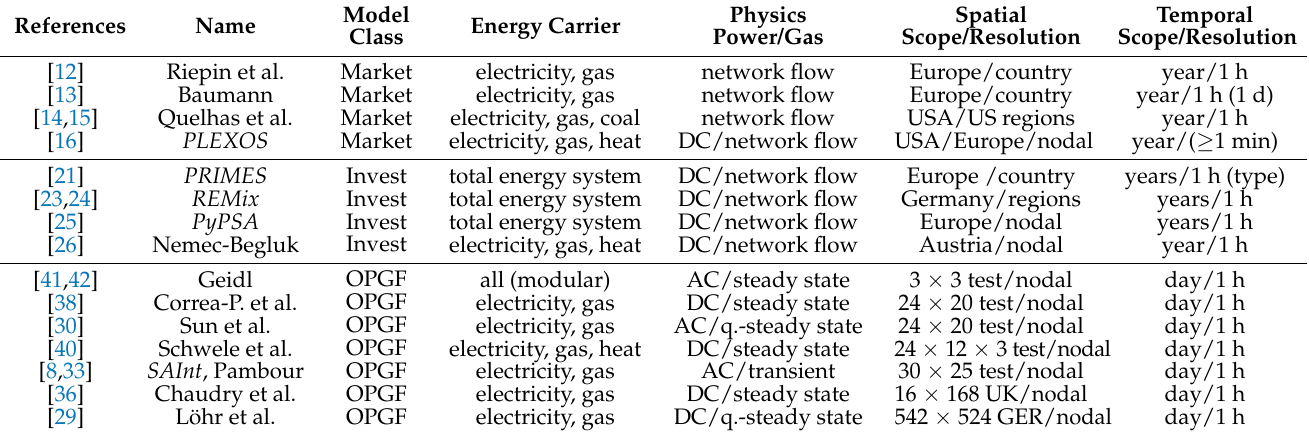
Table 1. Overview of selected existing dispatch models for integrated energy